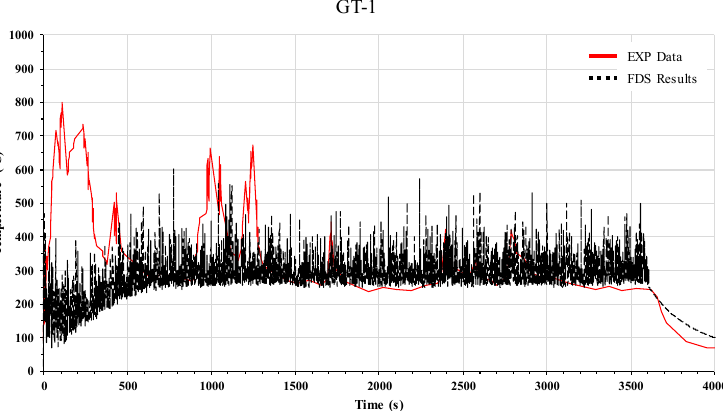
Figure 13. Gas cloud temperature over time at GT-1.